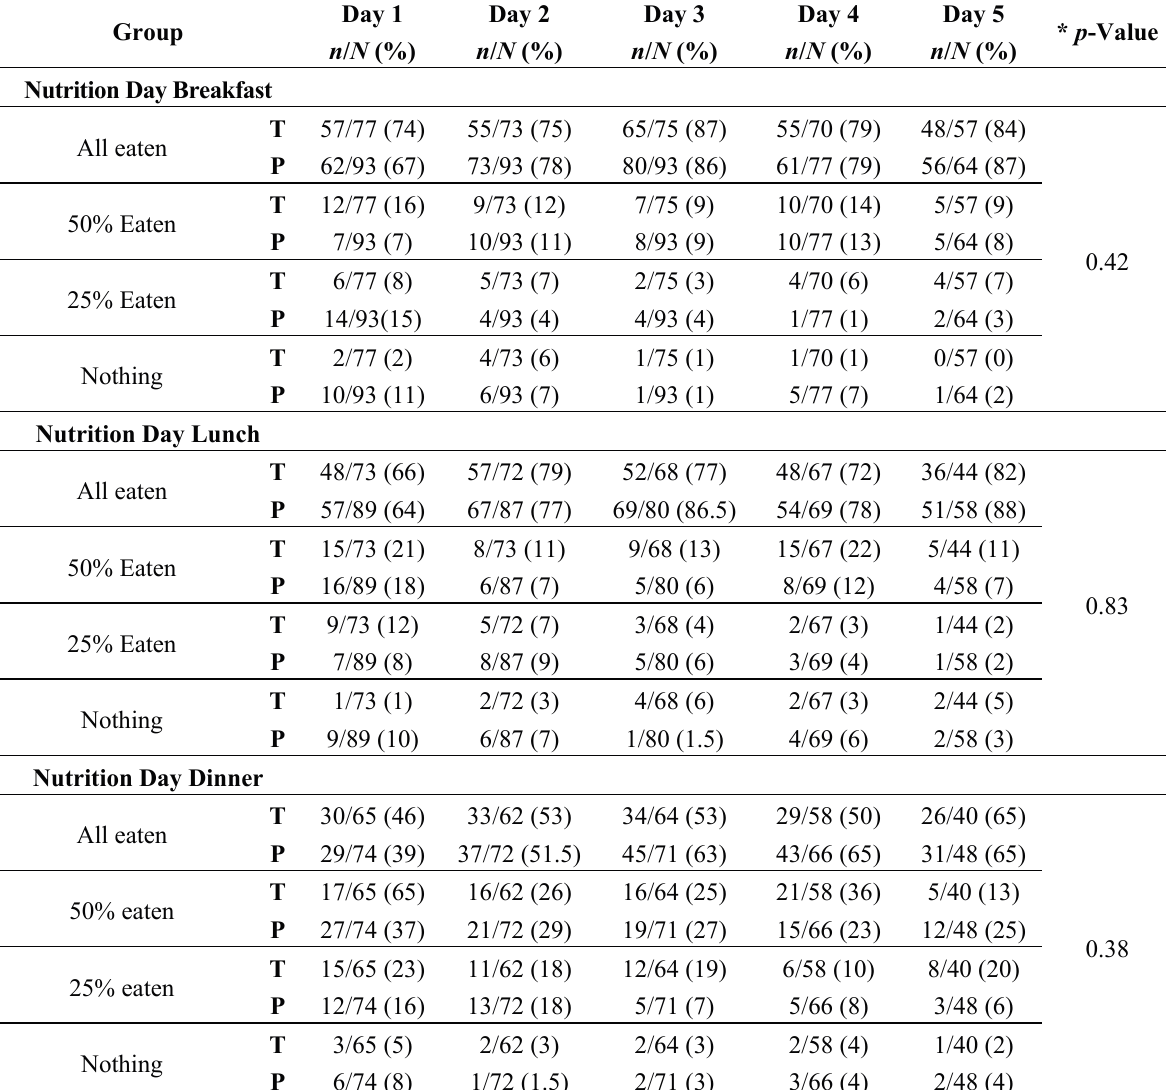
Table 3. Postoperative dietary intake according to “Nutrition Day in Europe”.